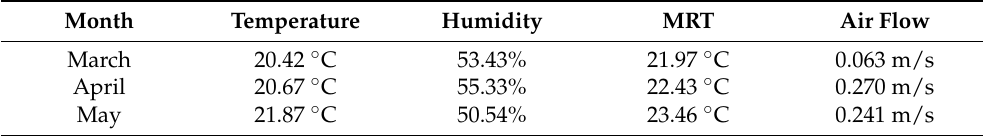
Table 2. Mean monthly values of monitored parameters of the first testing